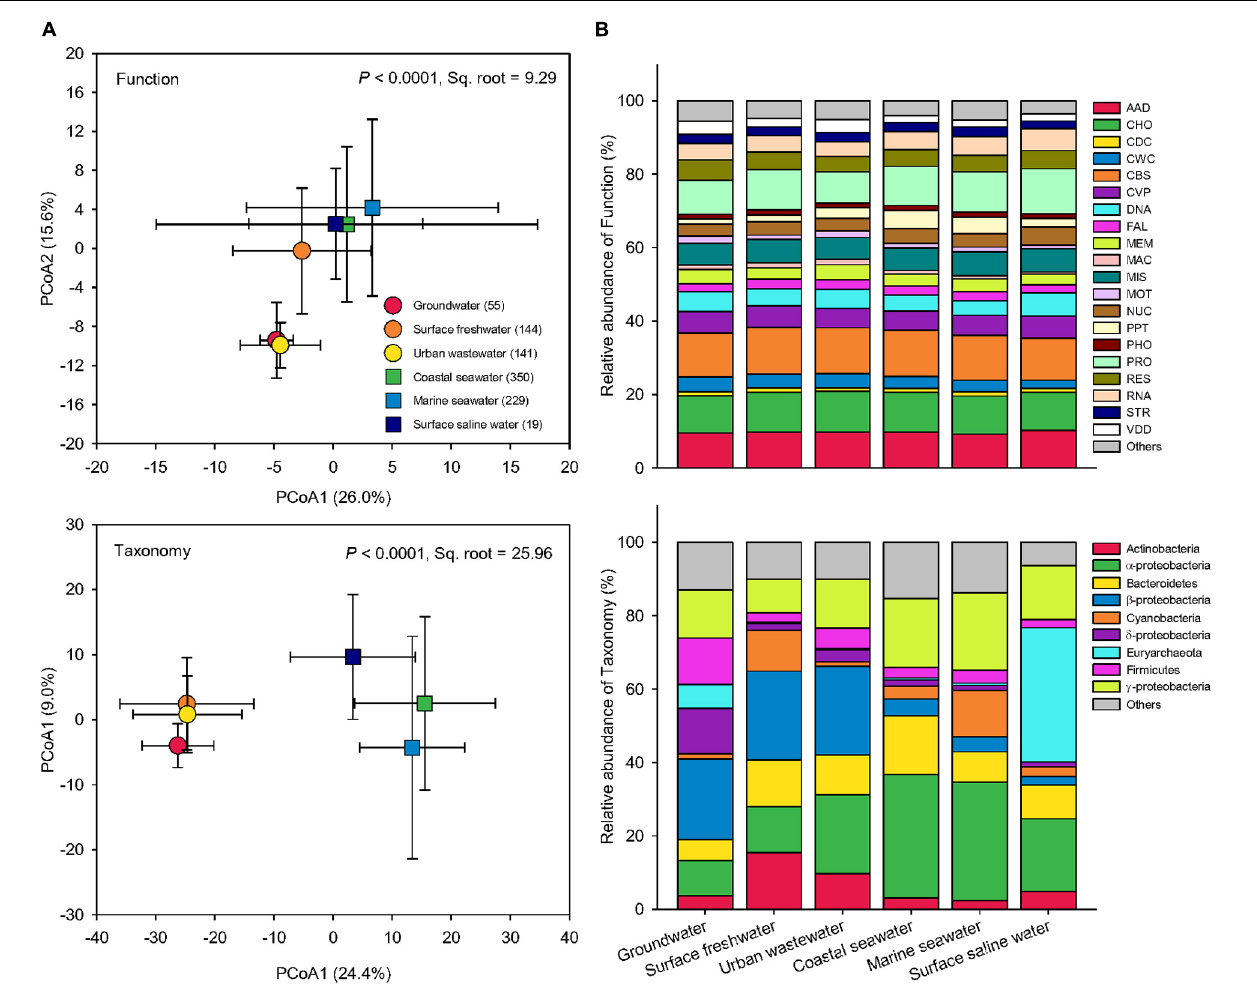
FIGURE 3 | Functional and taxonomic diversities across six water biomes. (A) Principal coordinates analysis (PCoA) showing beta-diversity of water metagenomes annotated in the Subsystems database at level 3 (Function) and RefSeq database at the genus level (Taxonomy) among six biomes. The error bars represent the standard deviation of data ranges. Sample sizes of each biome are given in parentheses. Variations explained by two principal coordinate dimensions are given in parentheses by percentage. P values and Sq. root of PERMANOVA are also given. (B) Relative abundance of dominant water metagenomes (mean > 1%) annotated in the Subsystems database at level 1 (Function), and the RefSeq database at the phylum/class levels (Taxonomy) among six water biomes. AAD, amino acids and derivatives; CHO, carbohydrates; CDC, cell division and cell cycle; CWC, cell wall and capsule; CBS, clustering-based subsystems; CVP, cofactors, vitamins, prosthetic groups, pigments; DNA, DNA metabolism; FAL, fatty acids, lipids, and isoprenoids; MEM, membrane transport; MAC, metabolism of aromatic compounds; MIS, miscellaneous; MOT, motility and chemotaxis; NUC, nucleosides and nucleotides; PPT, phages, prophages, transposable elements, plasmids; PHO, phosphorus metabolism; PRO, protein metabolism; RES, respiration; RNA, RNA metabolism; STR, stress response; VDD, virulence, disease and defense.